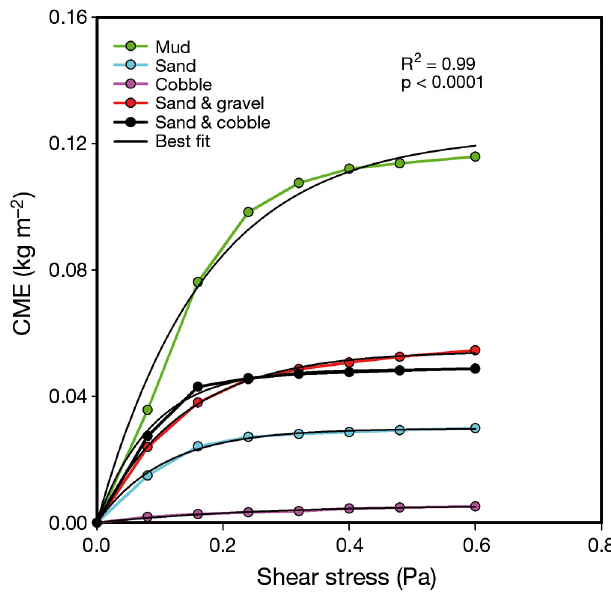
Fig. 5. Best fit plot of cumulative mass eroded (CME) versus shear stress for the erosion experiments (n = 6 per substrate type) using salmon fecal waste material. The fits are based on the simple exponential rise to maximum equation (see Eq. 3)